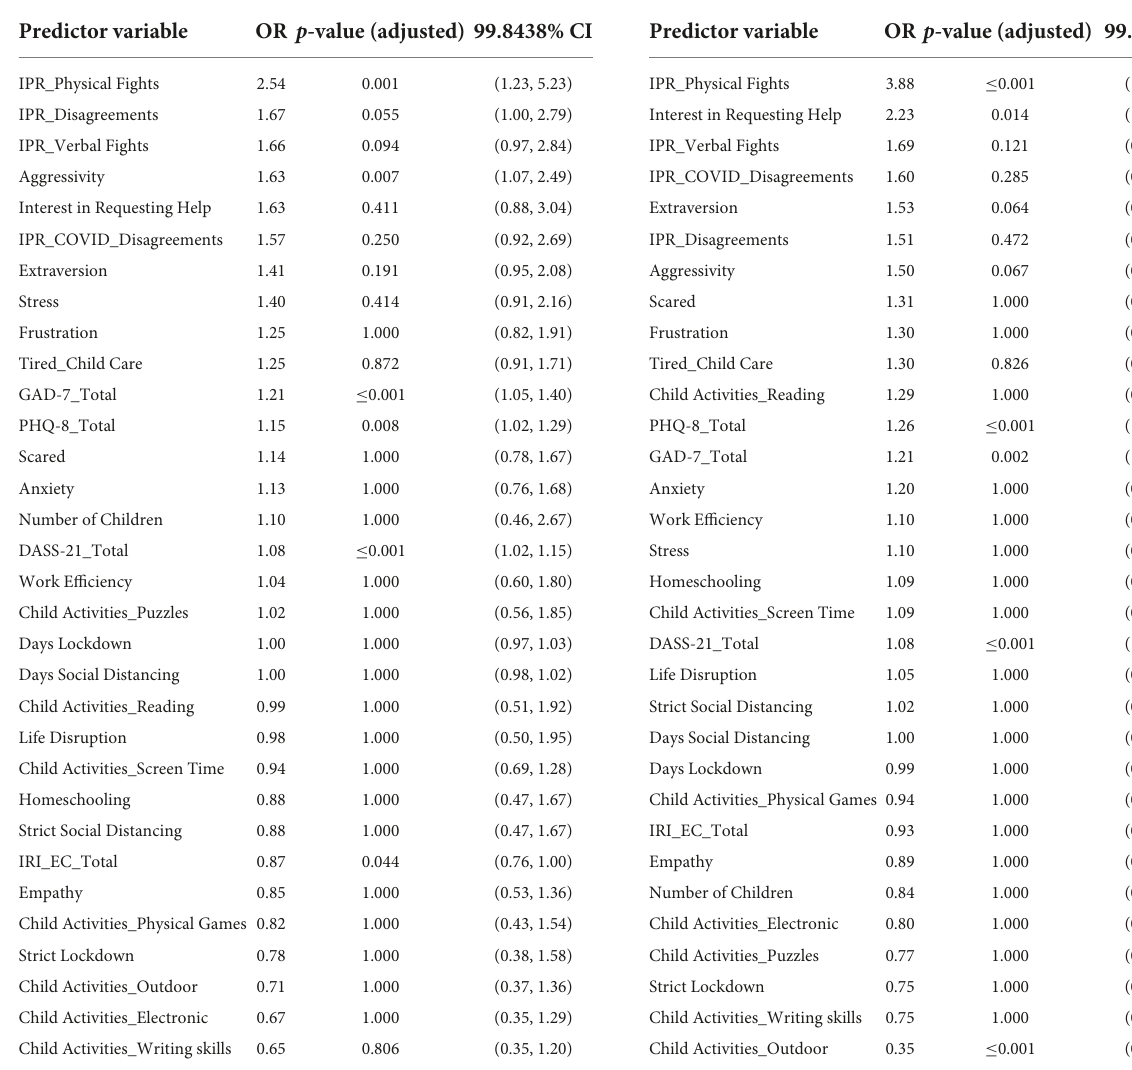
TABLE 3 (Time 3): Predictors of physical punishment toward children in the unregularized regression